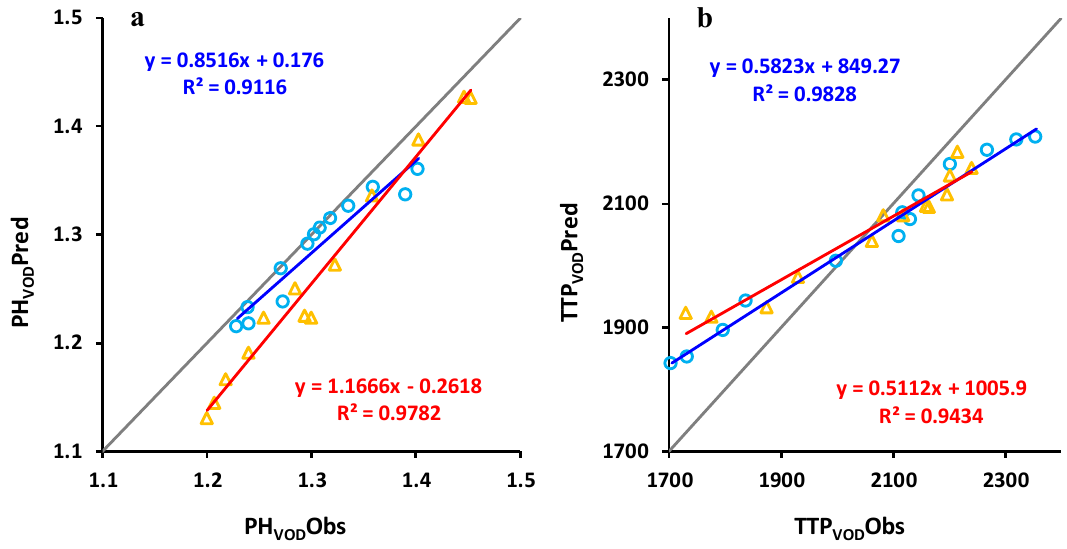
Figure 10. For the ND transect, (a) the Predicted Peak Height VOD (PH VOD Pred) and (b) the Predicted Thermal Time to Peak VOD (TTP VOD Pred) each as a function of growing season maximum value determined by the Observed Peak Height VOD (PH VOD Obs) and Observed Thermal Time to Peak VOD (TTP VOD Obs), respectively, where blue line with cyan triangles and blue text display g1 (2003–2005 plus 2007) and red line with golden circles and red text display g2 (2013–2016). The SD transect sites exhibited very similar properties (data not shown).